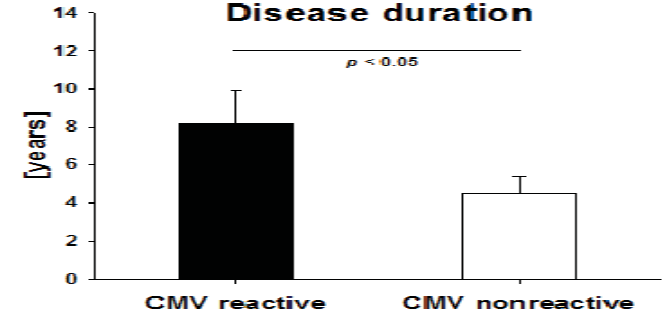
Figure 4. Disease duration in CMV reactive patients. Mean duration of Inflammatory Bowel Disease (Crohn’s disease and Ulcerative colitis) was established for patients who tested positive for CMV reactivity in GzB or PFN ELISPOT assays vs . nonresponders. Statistical significance was evaluated by Mann–Whitney rank sum